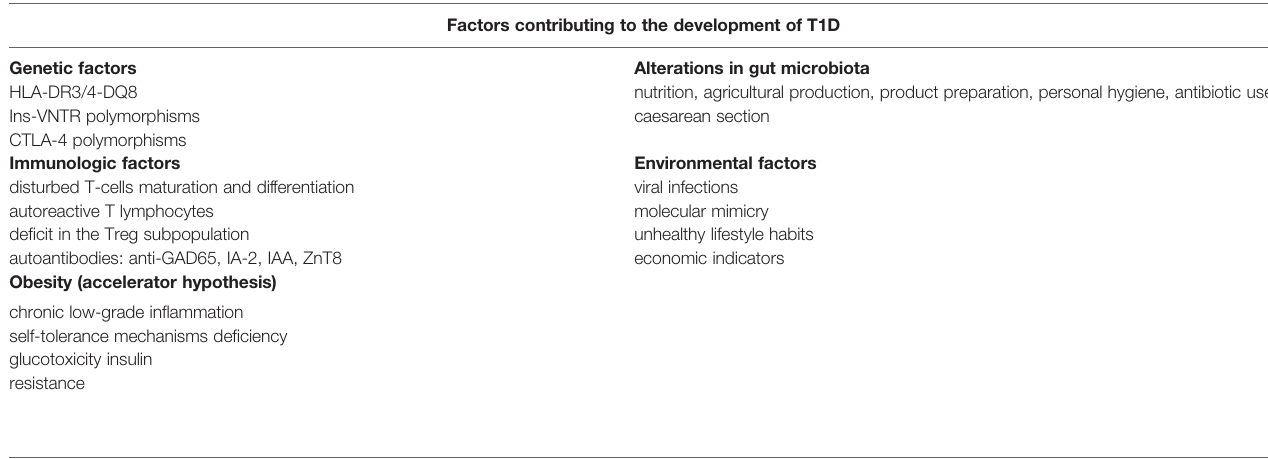
TABLE 1 | Factors contributing to the development of